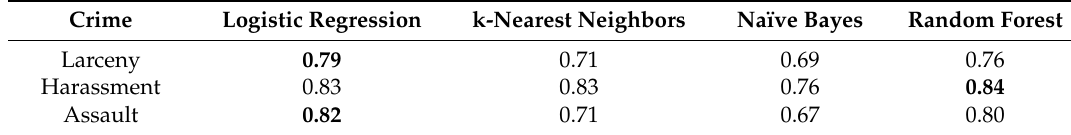
Table 4. Choosing the best performing prediction model based on accuracy.